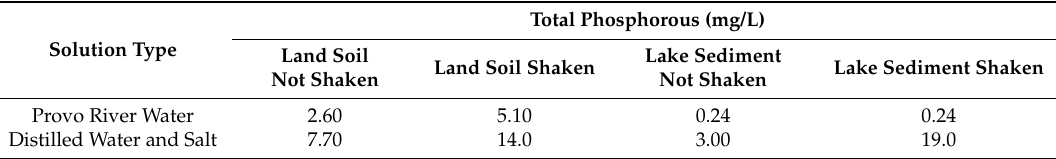
Table 4. Laboratory experimental